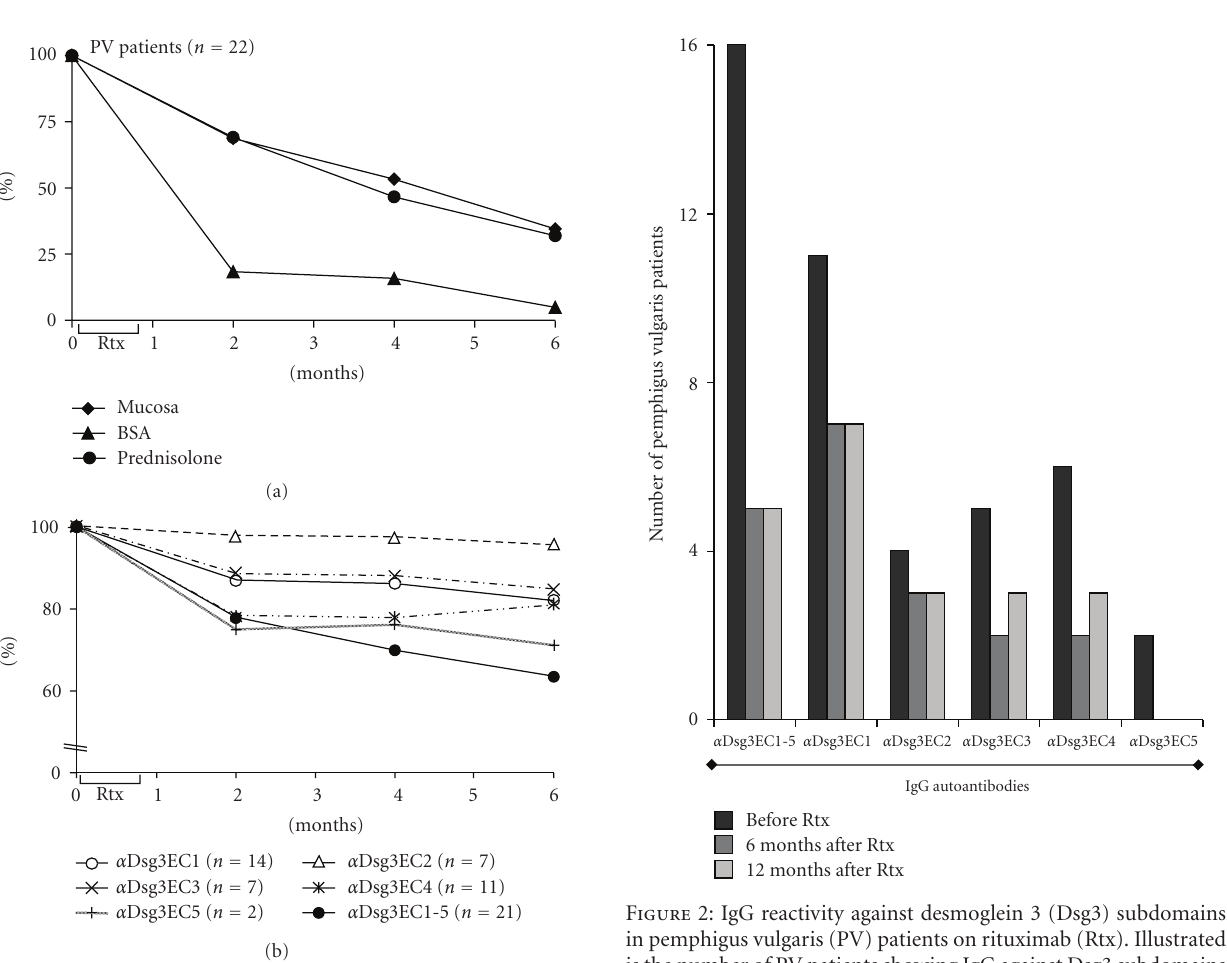
Figure 1: Rituximab (Rtx) treatment of pemphigus vulgaris (PV) patients leads to clinical improvement of skin and mucosal lesions and is accompanied by decreased IgG titers against distinct regions of desmoglein 3 (Dsg3) ectodomain. Treatment with Rtx of 22PV patients led to a significant improvement of mucosal and skin lesions and is expressed as reduced mucosal and body surface area (BSA) scores within 6 months after treatment (Figure 1(a)). In the same way, the dose of prednisolone was reduced (Figure 1(a)). By enzyme-linked immunosorbent assay, there was clearly a reduction of IgG reactivity against the Dsg3 ectodomain (Dsg3EC1-5) and defined regions of the Dsg3 ectodomain (Figure 1(b)). The number of studied patients or sera, respectively, is given in parenthesis. Rtx (time when rituximab was administered).